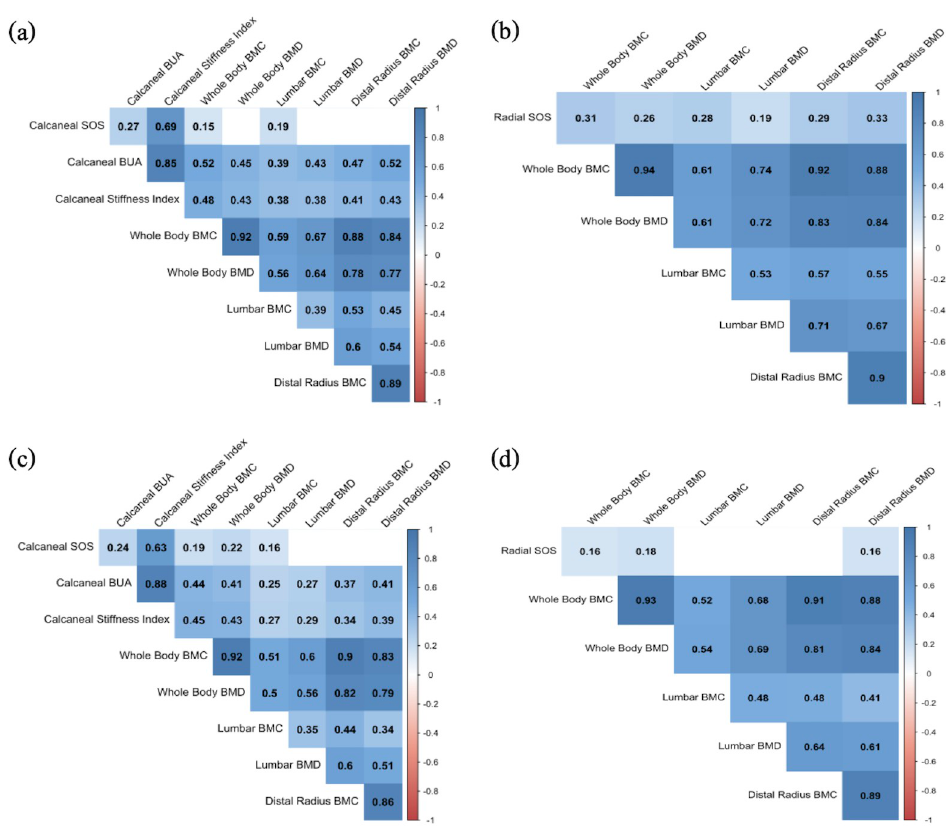
Fig 1. Correlations between QUS and DXA measures at baseline and follow-up, pooled across HIV groups. (a) Results of Spearman correlation between baseline calcaneal QUS measures and DXA (n = 170). (b) Results of Spearman correlation between baseline radial QUS measures and DXA (n = 205). Shaded cells indicate p < 0.05, with darker shading indicating more significant values. (c) Results of Spearman correlation between follow-up calcaneal QUS measures and DXA (n = 170). (d) Results of Spearman correlation between follow-up QUS measures and DXA (n = 205). Shaded cells indicate p < 0.05, with darker shading indicating more significant values. Numbers included within individual cells represent Spearman rho values. BMC: bone mineral content; BMD: bone mineral density; BUA: broadband ultrasound attenuation; SOS: speed of sound; DXA: dual-energy x-ray